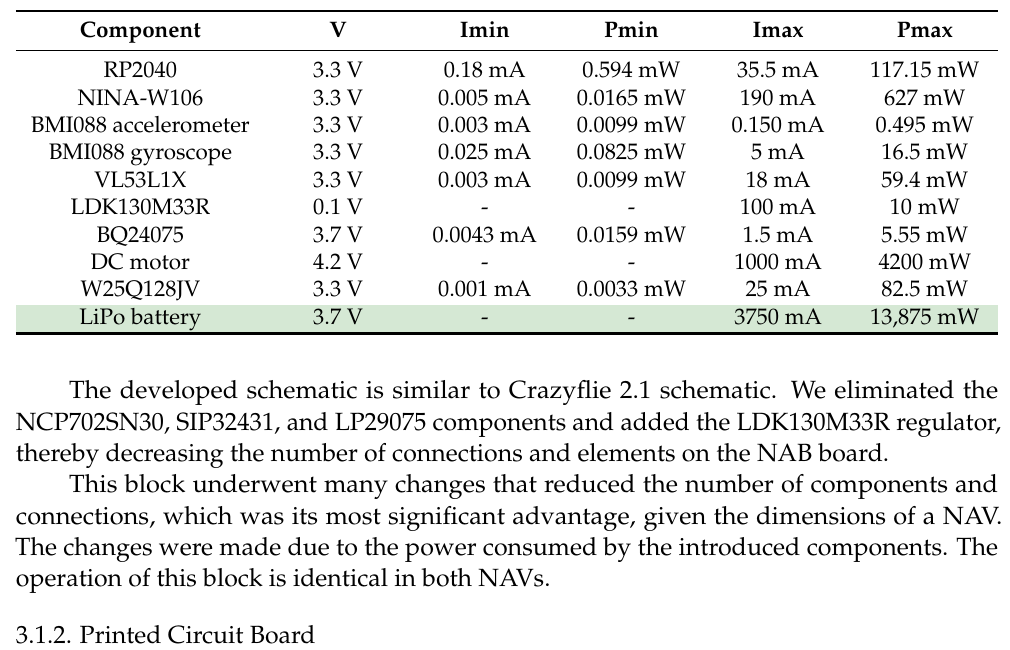
Table 7. Component consumption and power supplied by the LiPo